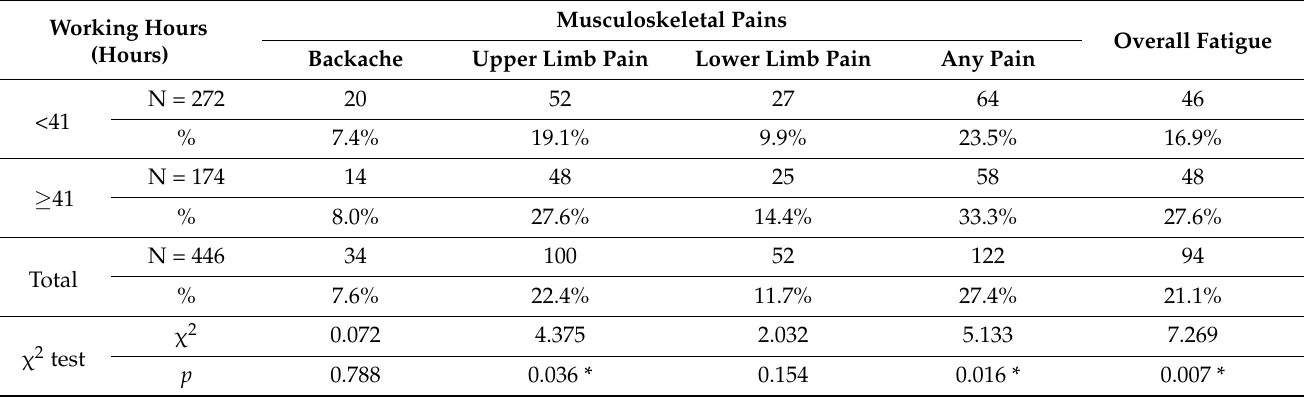
Table 5. Distribution of subjective musculoskeletal pains and overall fatigue by working hours.